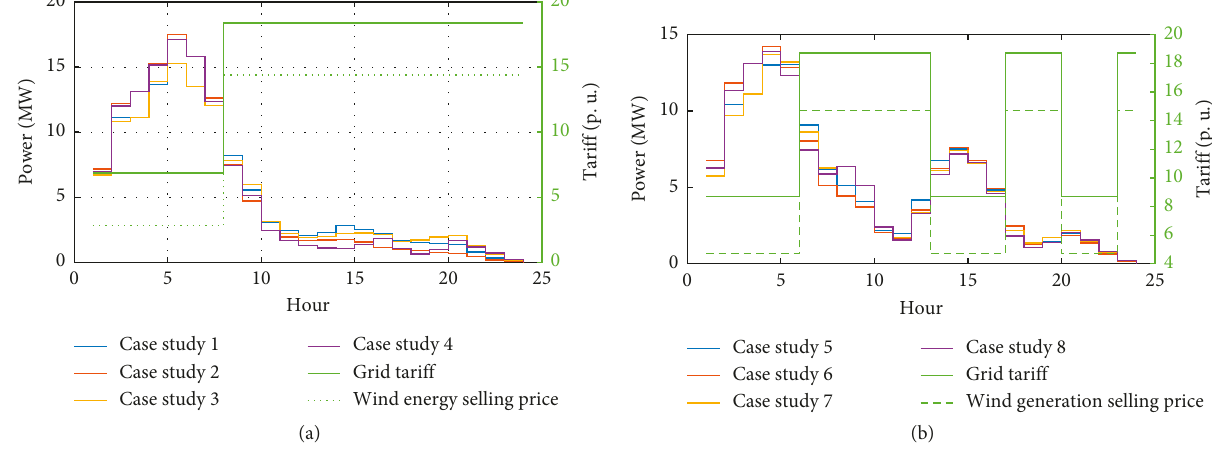
Figure 21: Demand of the community, grid tariff, and wind generation selling price for case studies (a) 1, 2, 3, and 4 and (b) 5, 6, 7, and 8.